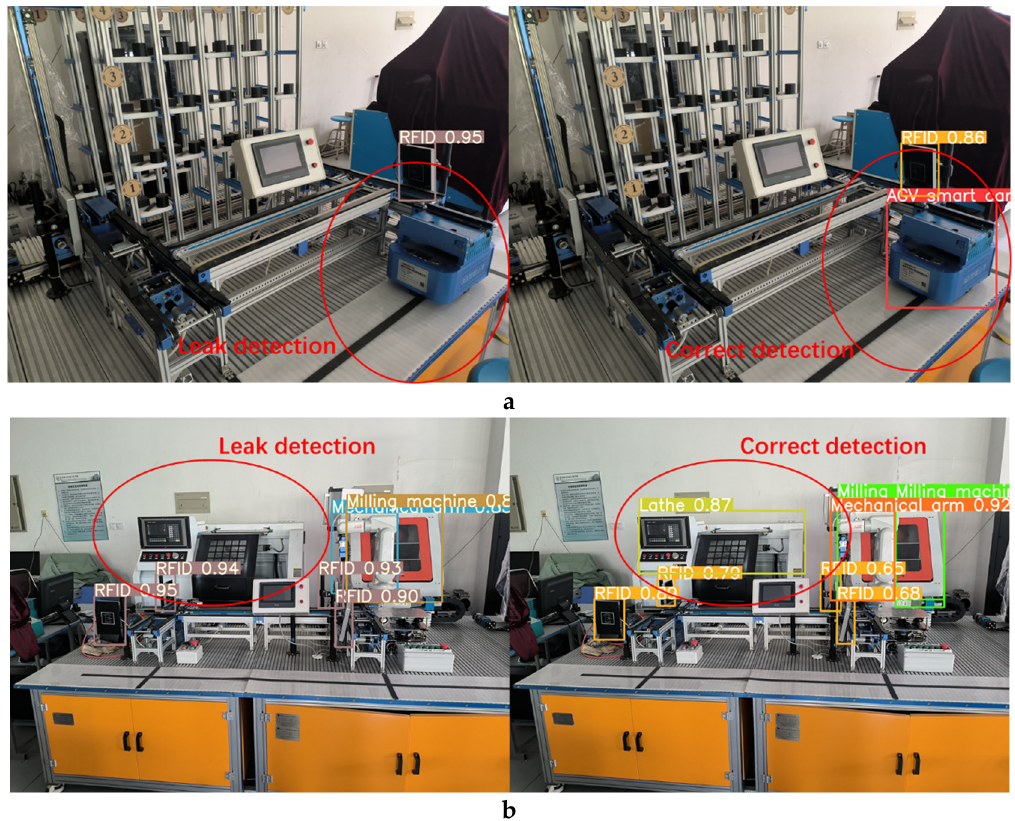
Figure 14. Comparison of recognition test results between YOLOv5-6.0 and the improved method.